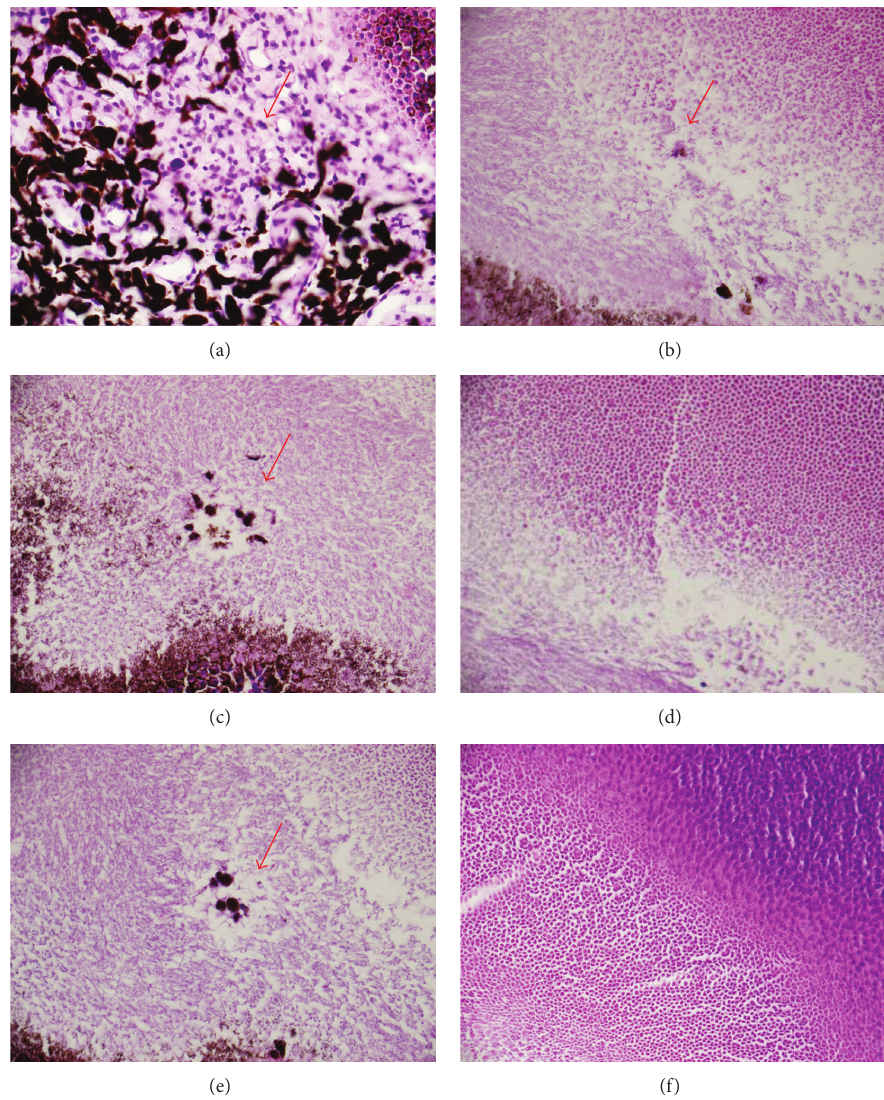
Figure 11: Subject S6 OD histological sections of a flat mount retina nine days after exposure (1,696J/cm 2 ). (a) Choroid, (b) outer segment of photoreceptors, (c)-(d) junction of inner and outer segment of photoreceptors, (e) inner segment of photoreceptors, and (f) junction of inner segment and outer nuclear layer. The choroid exhibits loss of pigment as well as low numbers of macrophages, lymphocytes, and plasma cells. There is disruption of the outer segments of the photoreceptors and pigment laden macrophages (b). (c) and (d) both show the junction of inner and outer segment of photoreceptors with minimal disruption of photoreceptors and two small pigment laden macrophages. The inner segment of photoreceptors with minimal disruption of photoreceptors (linear defect is an artifact) is shown in (e). The final frame (f) is the junction of inner segment and outer nuclear layer with no detectable